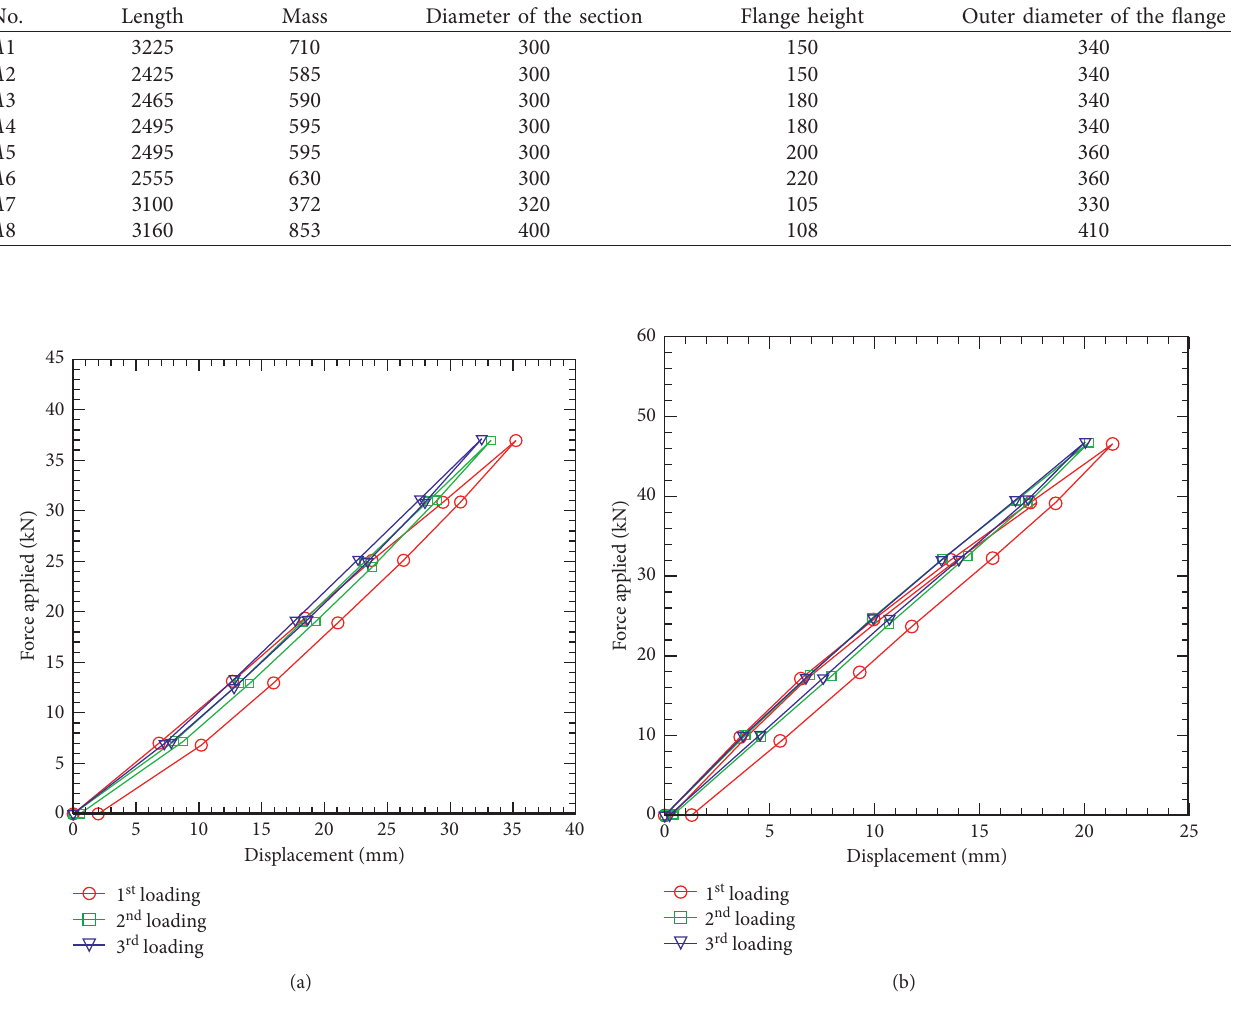
Figure 2: Curves of change of force applied on the top end of individual insulators A 1 (a) and A 6 (b) with the displacement of the top